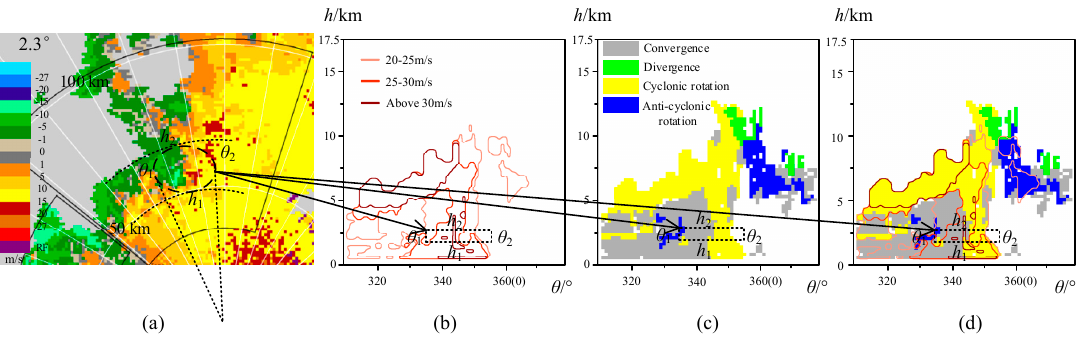
Figure 7. Diagrams of the projection map of the airflow field structure types and intensities (PMAFSTI): ( a ) A radial velocity map at the radar’s elevation angle of 2.3° and ( b , c , d ) PMAFSTI. In ( b ), the airflow field intensities greater than 20 m/s are discretized at intervals of 5 to draw the isolines from light red to dark red. In ( c ), the different structure types are labeled using four colors and ( d ) is the superposition of ( b ) and ( c ). In ( a ), a strong rotation structure in radial velocity map is marked by a dashed ellipse, which corresponds to the dashed rectangular areas in ( b ), ( c ), and ( d ).